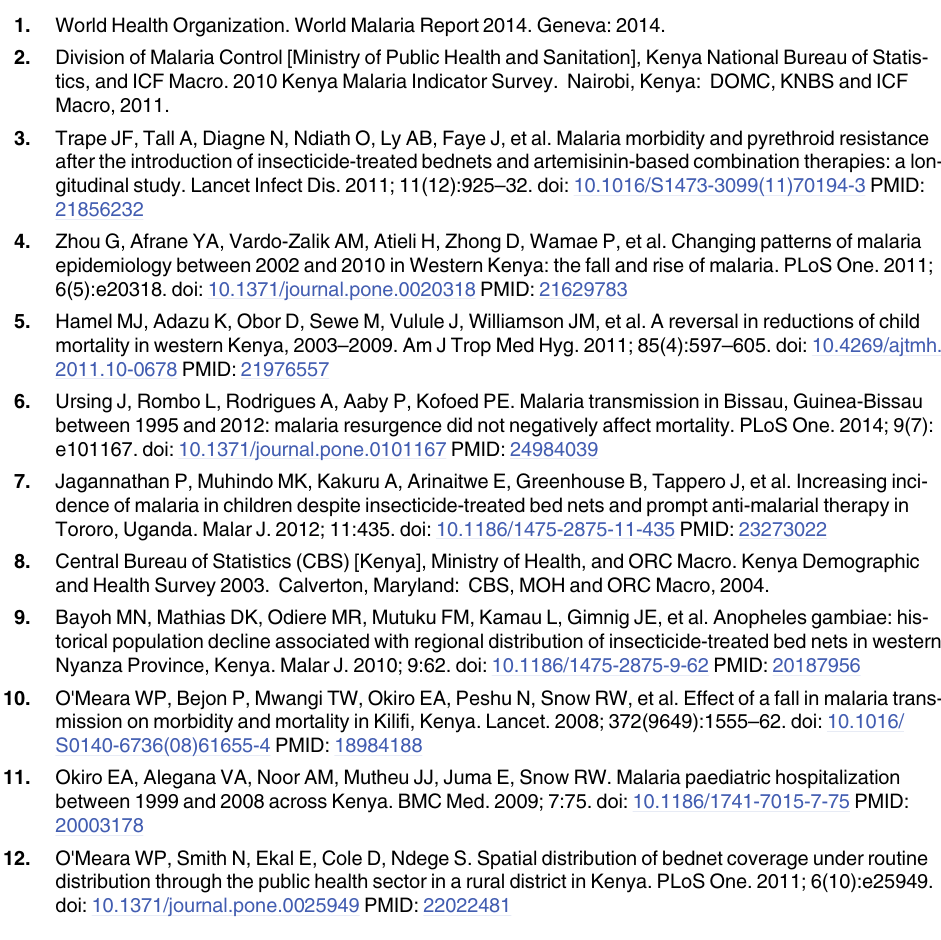
S1 Table. Unadjusted odds ratios for all variables tested in the